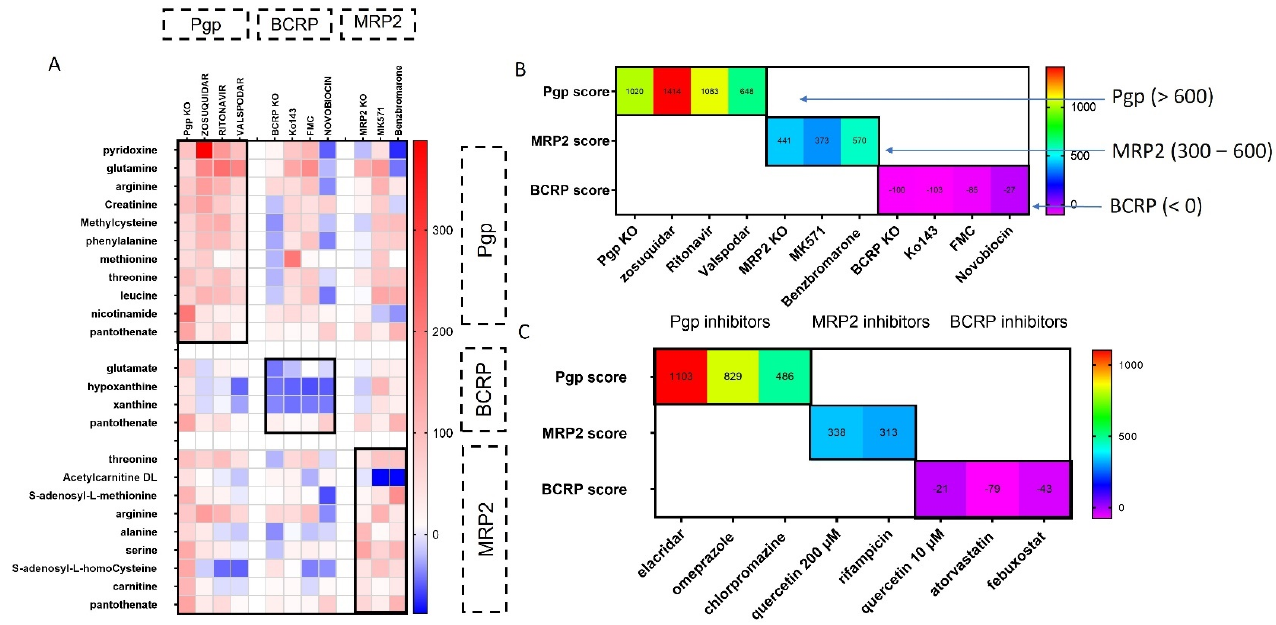
Figure 5. ( A ) Summary of changes in metabolites in Caco-2 cells in response to Pgp, BCRP, MRP2 inhibition and KO. The data representing changes with the main inhibitors was acquired from 3 individual experiments, and each experiment was performed with a minimum of 6 replicates. Changes in metabolites with additional inhibitors and KO cells are presented as mean of minimum 6 replicates from 1 independent experiment. The data are presented as the percentage change compared with control (DMSO/WT cells). ( B ) Scoring system for predicting Pgp, BCRP and MRP2 inhibition Pgp interaction: >600; MRP2: 300–600; BCRP interaction: <0. ( C ) Scoring system validation with additional inhibitors.